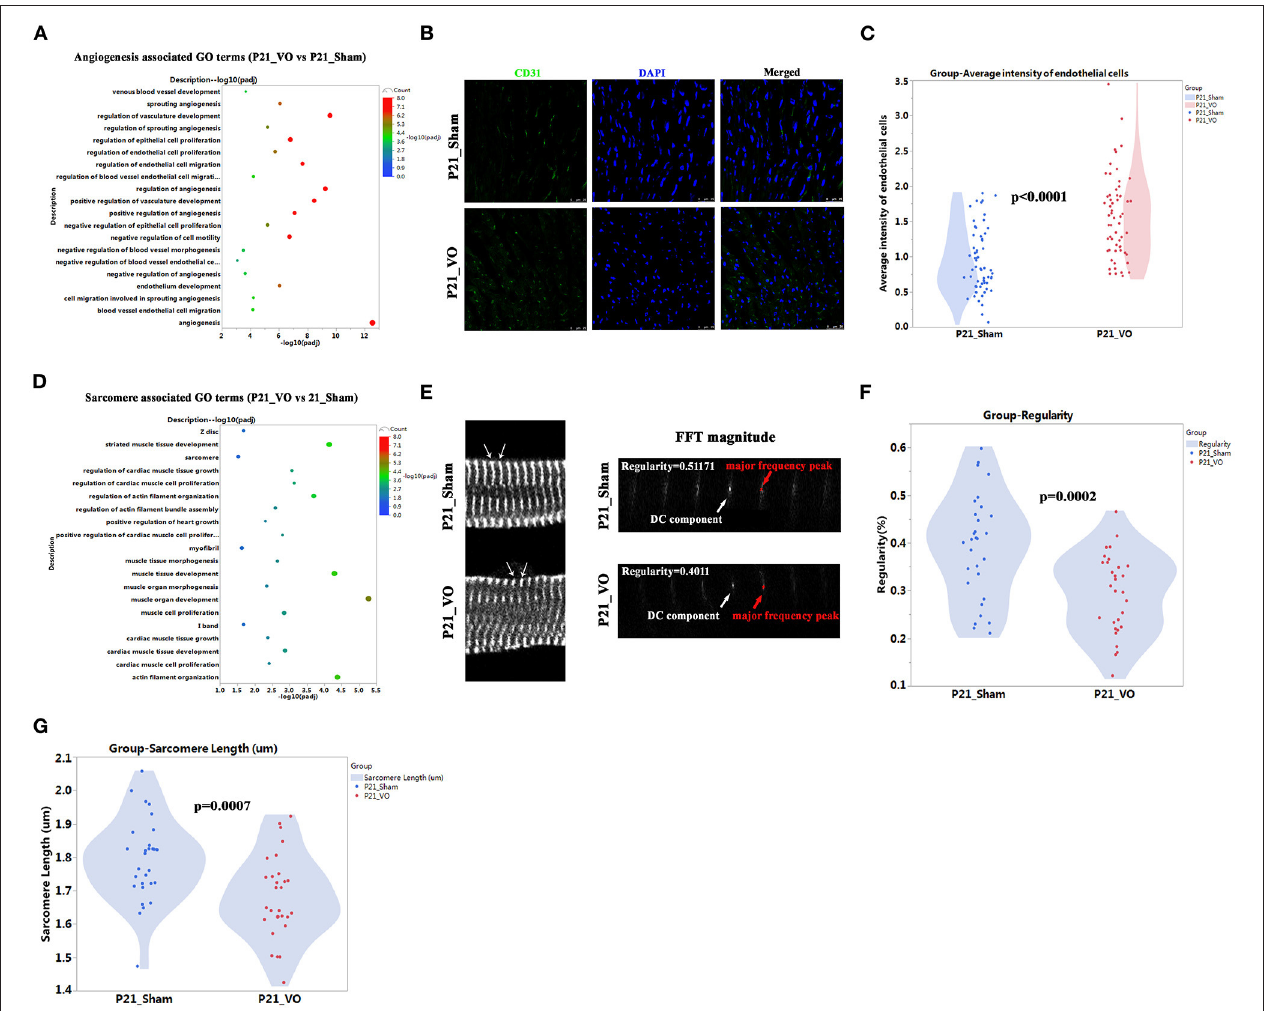
FIGURE 7 | The different angiogenesis and sarcomere maturation between normal and volume overload (VO)-influenced left ventricles (LVs) at P21. (A) The angiogenesis associated GO terms from GO analysis of DEGs between normal and VO-influenced LVs at P21. (B) Representative CD31-positive cells; CD31 (green), DAPI (blue). (C) Quantification of CD31-positive cells, n = 60 sections from 6 mice in each group, Student’s t -test. (D) The sarcomere associated GO terms from GO analysis of DEGs between normal and VO-influenced LVs at P21. (E) Left panel: representative of sarcomere organization from normal and VO-influenced LV at P21. Sarcomeric α -actinin (SAA, white), arrow indicated one sarcomere. Right panel: representative magnitude of fast Fourier transformation (FFT) of cardiomyocytes present at left panel; arrows indicated the major frequency peak, and the direct current (DC) component was defined as the transformed series at frequency 0, which represents the summation of signals of all pixels in the image; The major frequency was defined as the second highest peak; regularity is defined as the magnitude of the major frequency normalized to that of DC component. (F) Quantification of the sarcomere regularity from n = 30 cardiomyocytes in each group, Student’s t -test. (G) Quantification of the sarcomere length from n = 30 cardiomyocytes in each group, Student’s t